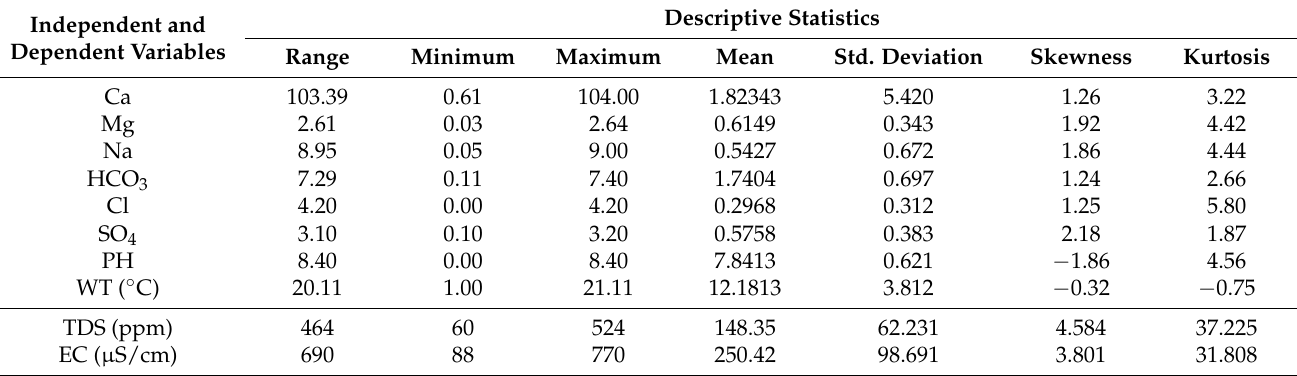
Table 1. Descriptive statical measures of collected